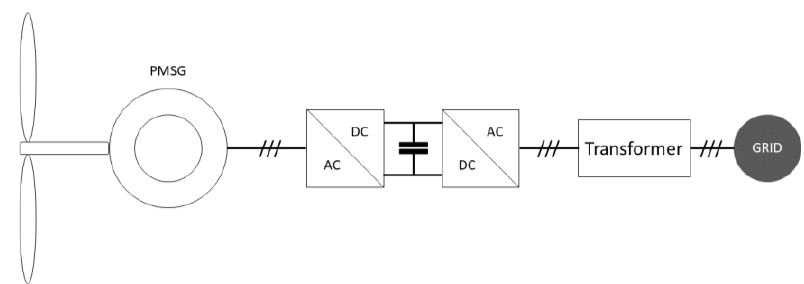
Figure 1. Type 4 Configuration for WECS with a PMSG.